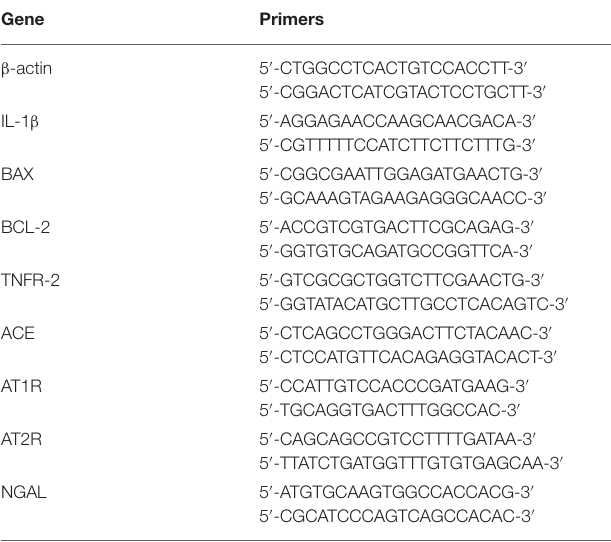
TABLE 1 | Sequences of primers used in real-time PCR